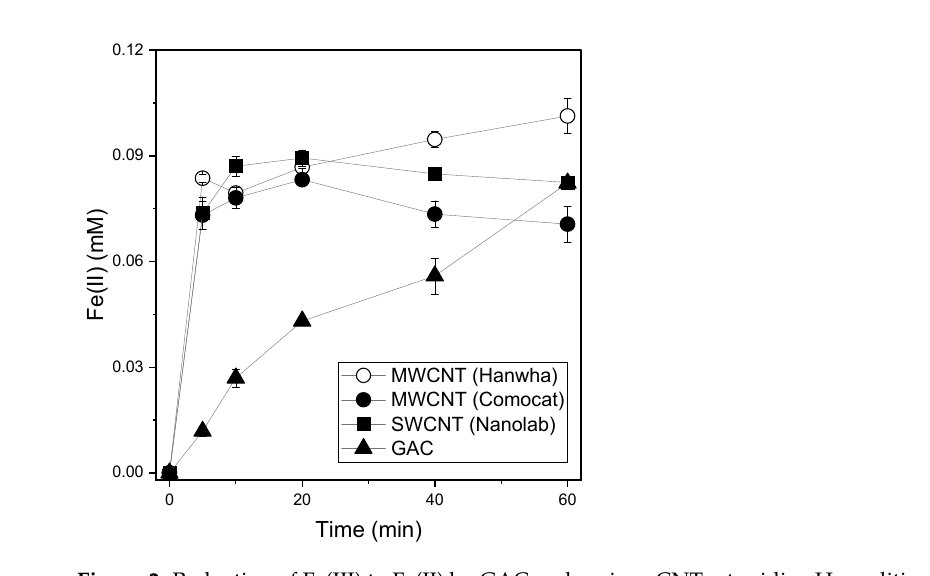
Figure 2. Reduction of Fe(III) to Fe(II) by GAC and various CNTs at acidic pH conditions ([Fe(III)] o = 0.2 mM, [CNT] o = [GAC] o = 1 g/L, pH o = 3, anaerobic condition, [reaction time = 60 min]). ing the concentration of the reduced forms of all the assessed compounds. In addition, the reduction degree (%) of the compounds was quantified using Equation (1) at reaction times of 5 min and 60 min, which are representative of early and longer reaction times, respec- tively. For the PMo 12 O 403 − compound, the reduction degree was estimated by comparing the degree of absorbance measured at the initial and sampling times.